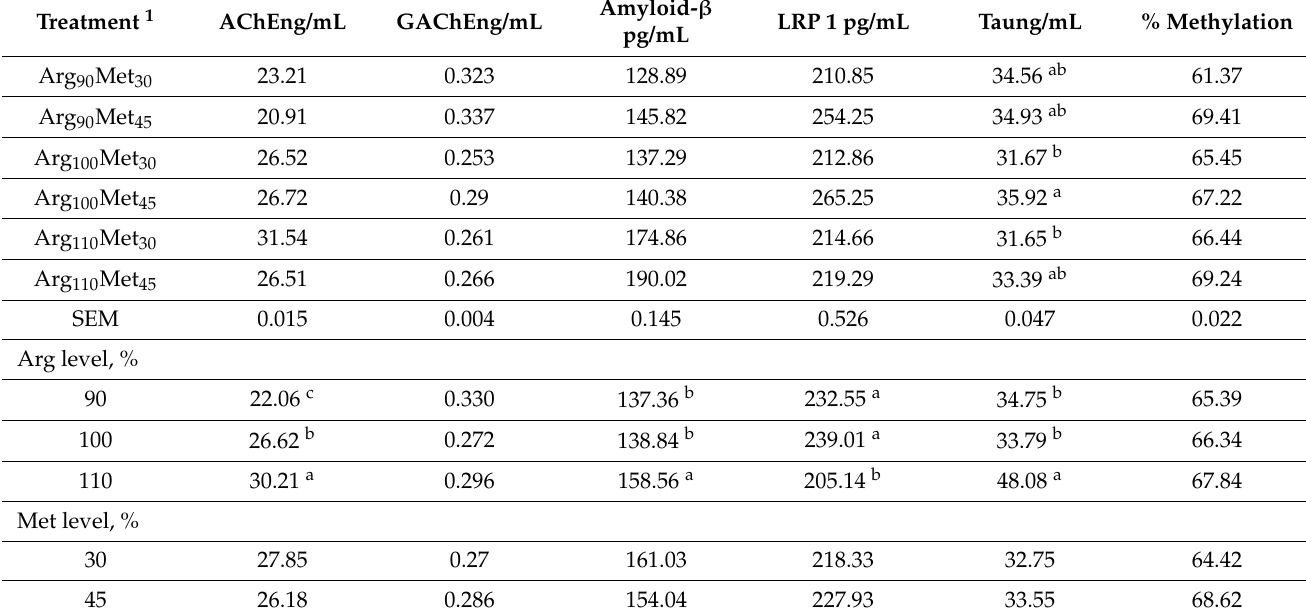
Table 5. Indicators of neurodegenerative changes in the brain of turkeys, Experiment